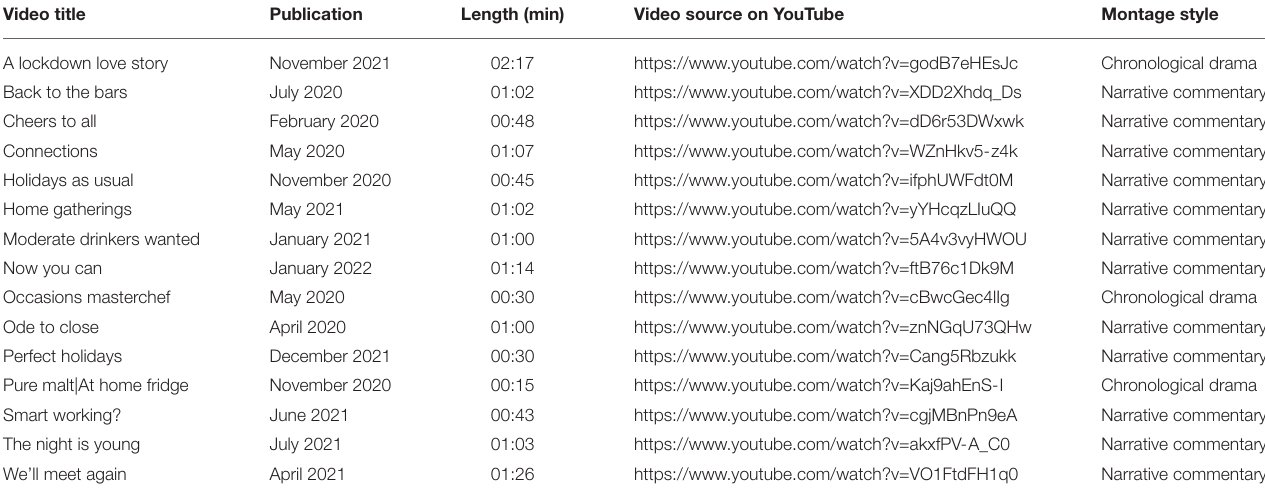
TABLE 2 | Overview of the Heineken TV commercials corpus used in this